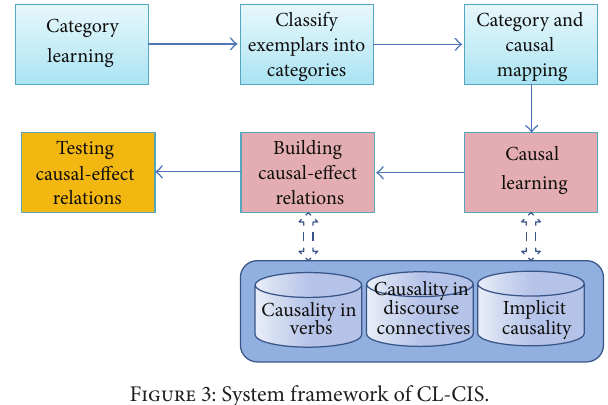
Figure 3: System framework of CL-CIS.